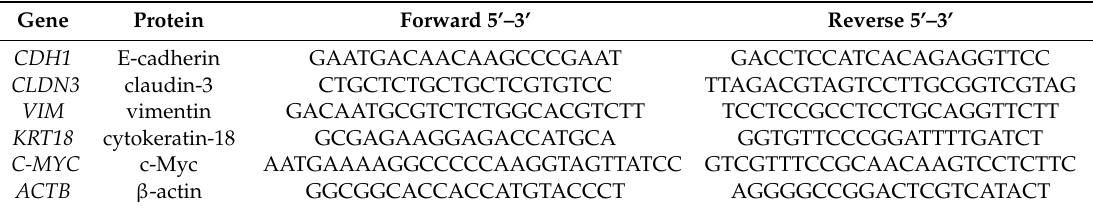
Table 1. Primer sequences used for